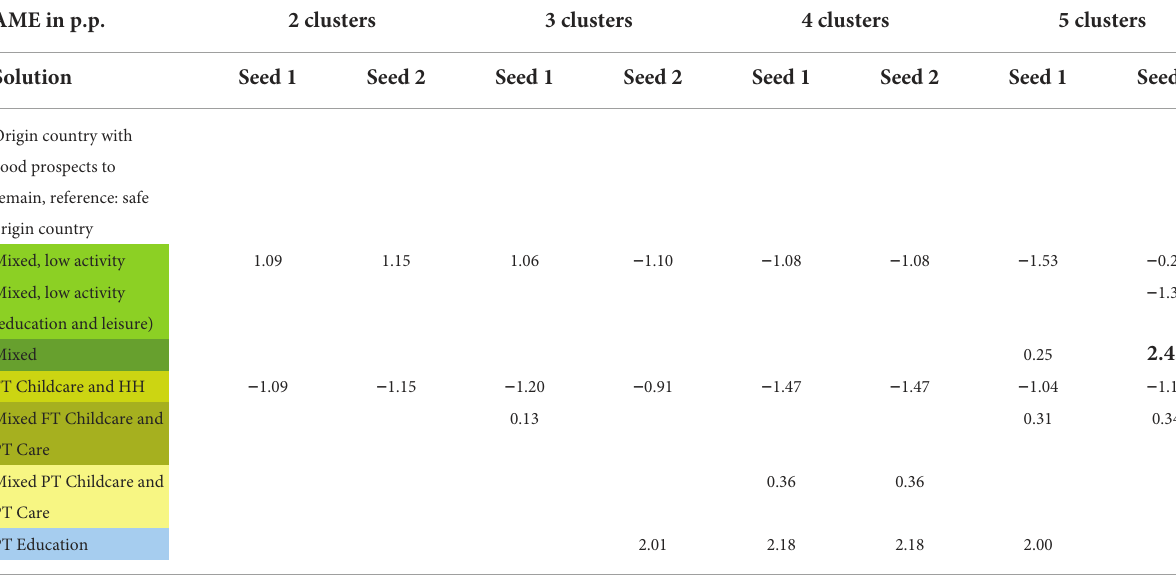
TABLE 7 Pooled analyses: the role of good prospects to remain. AME in